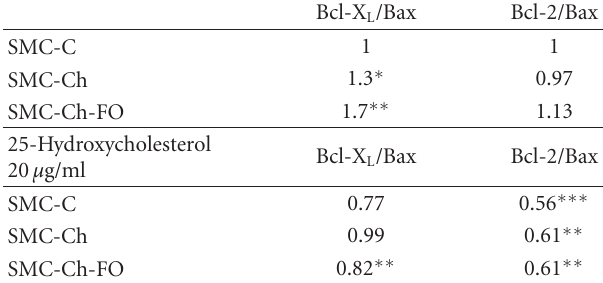
Figure 1: Toxicity of 25-hydroxycholesterol to SMC as measured by MTT assay. SMCs were treated with 25-hydroxycholesterol for 24 hours. Lowest values indicate highest toxicity. Results represent mean values ± SEM ( n = 3). ( ∗ P ≤ . 05, ∗∗ P ≤ . 01, ∗∗∗ P ≤ . 001).